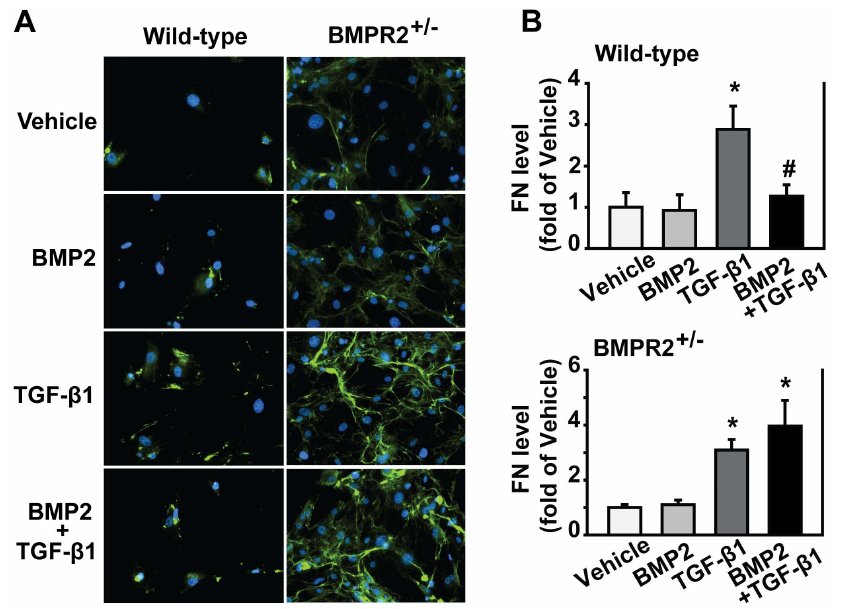
Figure 7. BMP2/pSmad1/5/8 signaling inhibited TGF- b -induced fibronectin in PSCs. (A) Wild-type and BMPR2 + / 2 PSCs were pretreated with 250 ng/ml of BMP2 for 30 min followed by 1 ng/ml of TGF- b 1 for 48 h. Immunofluorescence was performed using antibody against FN (green), and the cell nucleus was stained with DAPI (blue). The images of FN merged with DAPI were presented. (B) Quantification of fluorescence intensity from 5–10 different fields per slide, * P , 0.05 compared with vehicle group, # P , 0.05 compared with TGF- b 1 group. Original magnification 6 200.